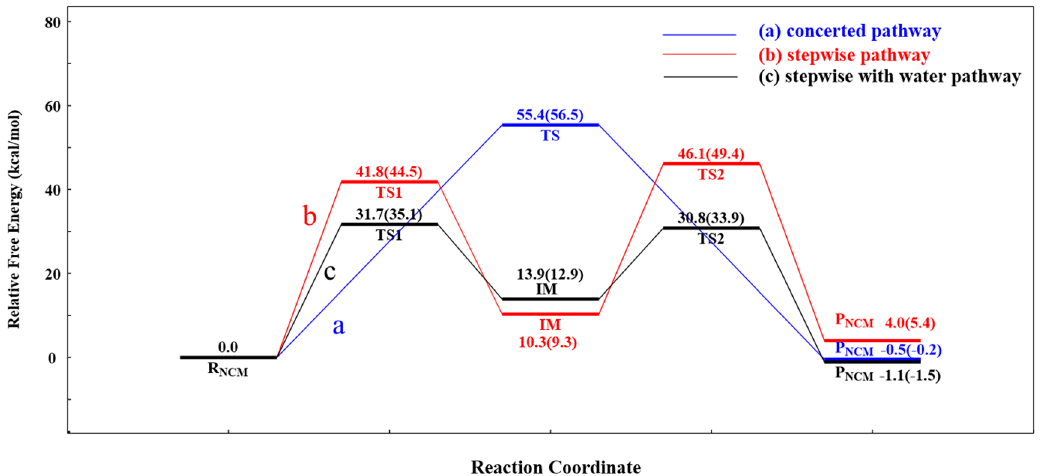
Figure 4. The calculated NCM of the AM free energy profiles: concerted pathway ( a ); stepwise pathway ( b ); stepwise pathway with the aid of water ( c ) in the solution with a thermal correction to the Gibbs free energy and in the gas phase (in parentheses), with zero-point energy (ZPE) correction. Relative free energies to the reactant are given in kcal/mol.